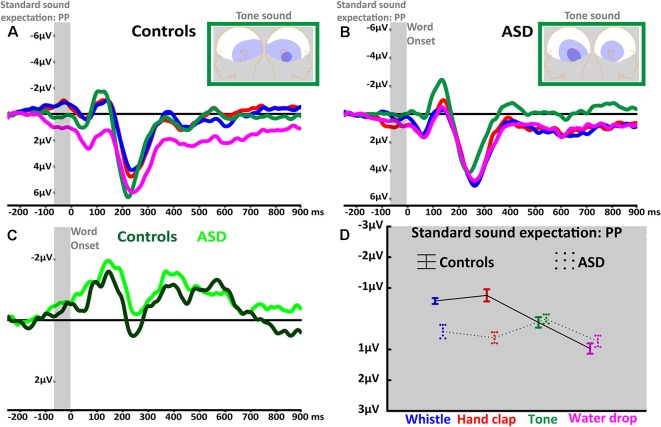
Anticipatory prediction potential (PP) and stimulus-elicited ERPs related to standard (prime) sounds. (A) PP curves in anticipation of face (blue), hand (red), tone (green) and water drop (magenta) sounds recorded at central electrodes (average of FC1, FCz, FC2, C1, Cz, C2, CP1, CPz, CP2) in typically developed (TD) participants. The light gray window shows the average PP of the last 60 ms before word onset. (B) PP curves in anticipation of face (blue), hand (red), tone (green) and water drop (magenta) sounds recorded at central electrodes in autism spectrum disorders (ASD) participants. (C) PP curves in anticipation of pure
tone sound in TD (dark green) and ASD (light green) from lateral electrodes (average of T7, TP7, TP9). The light gray window shows the last 60 ms before word onset when participants expect to perceive the standard sound. (D) The statistically significant interaction of Sound and Group revealed by PP average amplitudes; whiskers indicate standard errors of the mean.